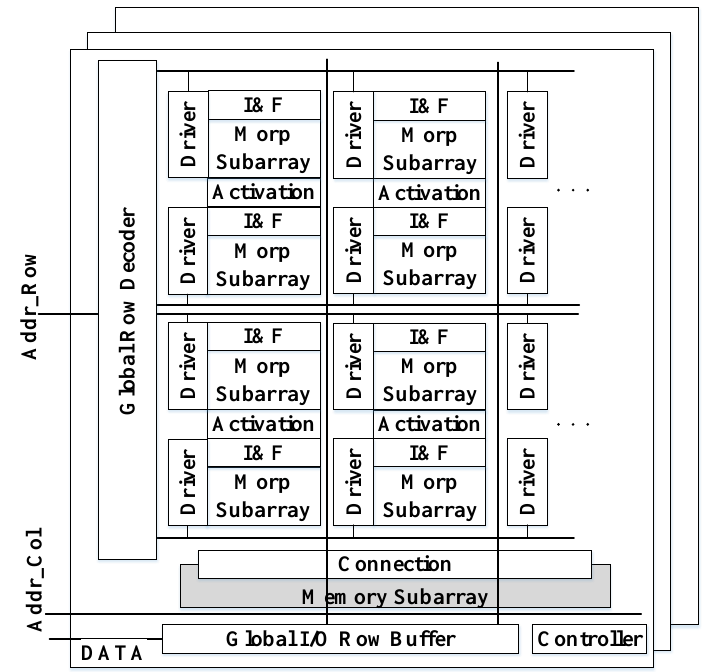
Figure 21. Overview of the PipeLayer architecture. (adapted from